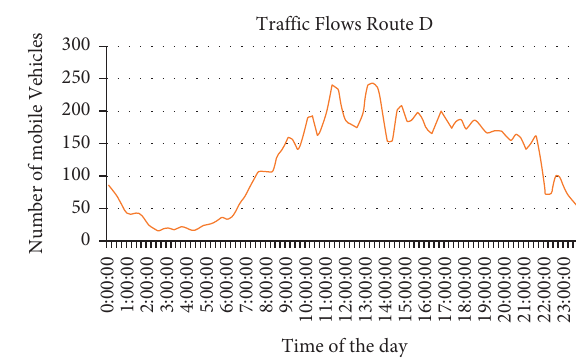
Figure 11: Traffic flow: route